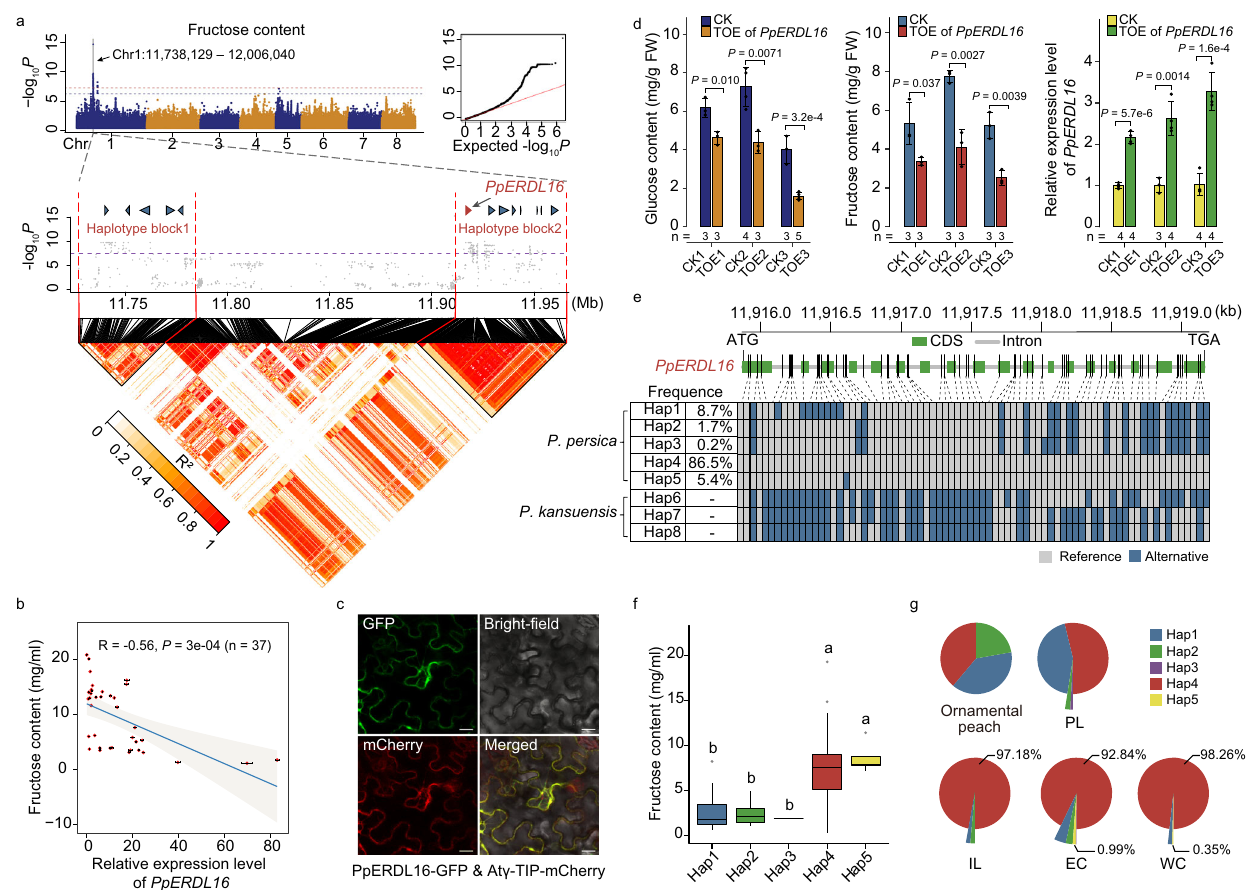
Fig. 5 Identi fi cation of PpERDL16 and its contribution to increased fructose accumulation during peach improvement. a Two signi fi cantly associated haplotype blocks of the major GWAS locus for fructose content. The horizontal lines depict the Bonferroni-adjusted signi fi cance threshold (red) and Permutation threshold (blue) in the Manhattan plot (top). The two signi fi cantly associated haplotype blocks are represented by red triangles surrounding black lines in the heatmap (bottom). The 13 protein-coding genes (including PpERDL16 in red) in these two haplotype blocks are shown as colored arrows. b A signi fi cantly negative correlation between fructose content and the PpERDL16 expression level in 37 peach accessions. Data were presented as the mean ± SD. Signi fi cance was tested with two-sided Student ’ s t -tests. c Confocal imaging of tonoplast localization of the transiently expressed PpERDL16-GFP fusion protein in tobacco leaf cells using the At γ -TIP-mCherry fusion protein as the positive control. Three independent experiments were performed with similar results. Scale bar, 20 μ m. d Signi fi cantly reduced levels of both the glucose (left) and fructose (middle) content in peach mesocarp tissues transiently overexpressing (TOE) PpERDL16 (right). Fruit mesocarps transiently transformed with the empty vector were used as controls (CK). FW fresh weight. The number ( n ) of each independent experiment are shown below. Data were presented as the mean ± SD. Signi fi cance was tested with two-sided Student ’ s t -tests. e Gene structure and haplotypes of PpERDL16 among peach ( P. persica ) accessions, as well as P. kansuensis accessions. The frequency for each haplotype is calculated for the P. persica accessions. f The distribution of the fructose content of each haplotype type was displayed in the box plot. Multiple comparison was conducted using least sgni fi cant difference (LSD) test. In the box plots, central line: median values; bounds of box: 25th and 75th percentiles; whiskers: 1.5 * IQR (IQR: the interquartile range between the 25th and 75th percentile). g The frequency distribution of PpERDL16 haplotypes (Hap1 – 5) in different types of P. persica accessions (ornamental peaches, PLs, ILs, ECs, and WCs). The different colored portions in each pie chart represent the percentage of different haplotypes. The percentage values of Hap4 and Hap5 exhibiting higher fructose content were displayed. Source data underlying Fig. 5b – g are provided as a Source Data fi